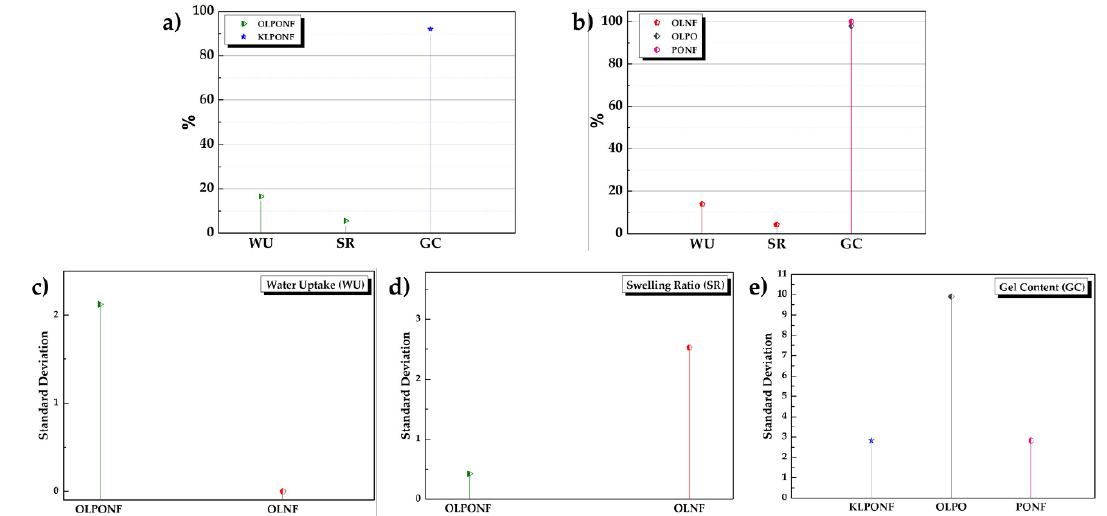
Figure 3. ( a , b ) Representation of the percentage rate of water uptake (WU), swelling ratio (SR), and gel content (GC) contents in different composite membranes. ( c – e ) Error statistical analysis via standard deviations (SD) with respect to their mean values.